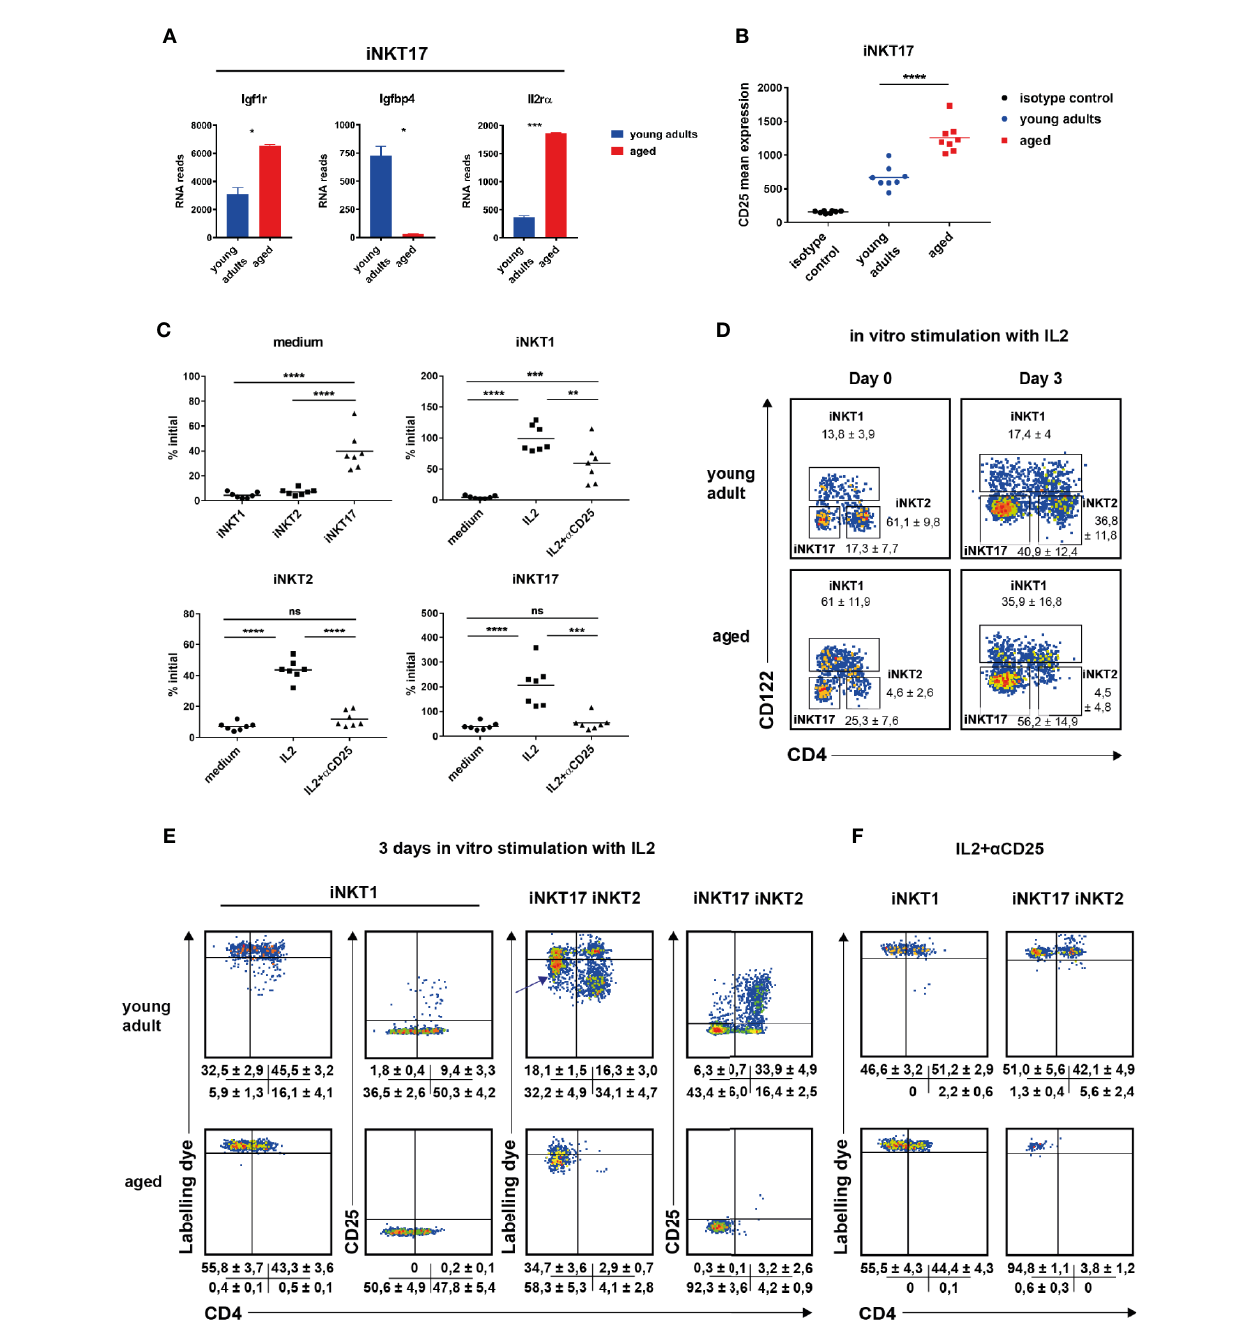
FIGURE 4 | The role of IL2 in invariant natural killer T (iNKT) cell homeostasis. (A) Igf1r , Igfbp4 , and IL2ra RNA reads (mean ± sd) in thymic iNKT17 cells from young adult and aged BALB/c mice. Data source as in Figure 2 . (B) CD25 mean expression in thymic iNKT17 cells from young adult and aged BALB/c animals determined by fl ow cytometry. Gating as shown in Figure 1A . Data are collected from four independent experiments. Each dot represents data from one animal. (C – F) In vitro effects of recombinant IL2. Sorts and stains to obtain labeled iNKT cells were done as described in Materials and Methods . (C) Shown are % of initial cell numbers (day 0) on day 3 in medium or in the presence of IL2 ± anti CD25 antibody ( a CD25). Data were collected from seven independent experiments (dots). (D) Representative fl ow cytometry plots of iNKT cells from young adult and aged BALB/c thymus on day 0 and day 3 after stimulation with IL2. Average frequencies (± SD) are given summarizing seven (aged) and eight (young adult) experiments. (E, F) Representative fl ow cytometry plots of the indicated iNKT subpopulations as gated in (D) showing distribution of cell tracker dye and CD25 levels on day 3 after stimulation with IL2 ± a CD25. Shown are the average frequencies for cells in the corresponding gates ( ± SD) underneath of each panel summarizing 5 – 7 independent experiments. Unpaired t test was performed in (A) . One-way ANOVA followed by Tukey ’ s multiple comparisons test were performed in (B, C) . *p < 0.05, **p < 0.01, ***p < 0.001, ****p < 0.0001, ns, not signi fi